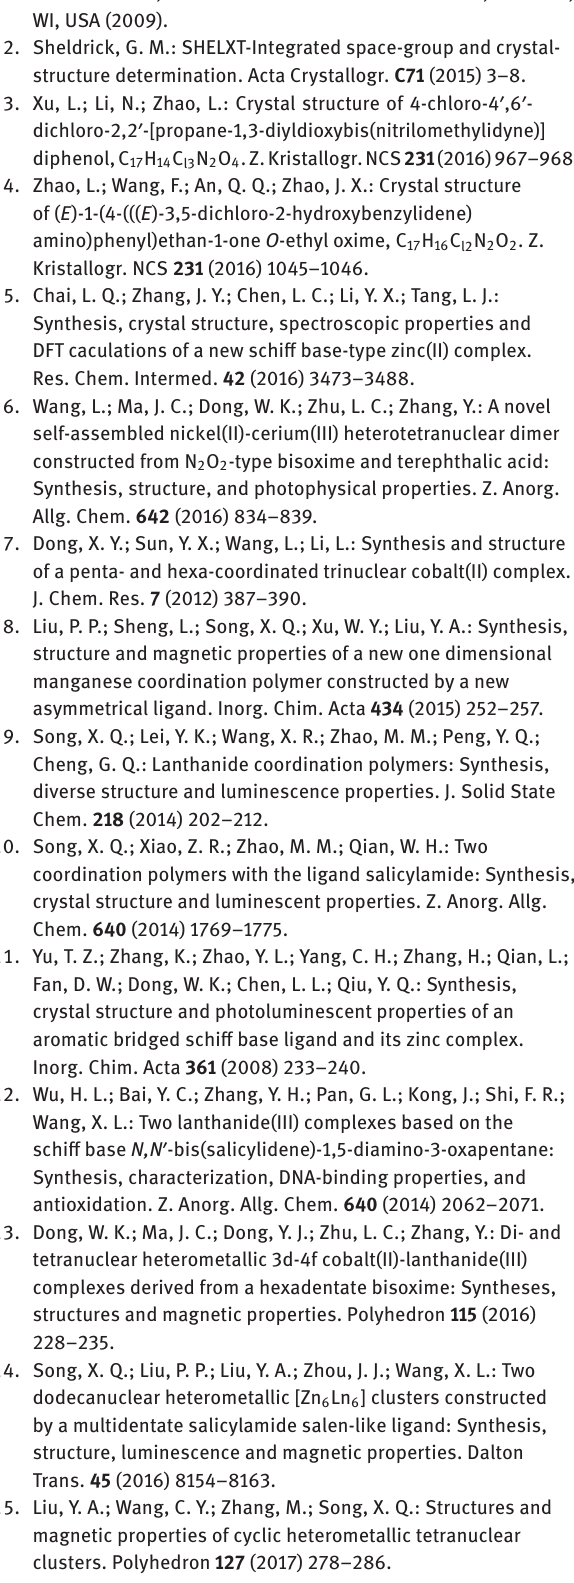
Table 2: Fractional atomic coordinates and isotropic or equivalent isotropic displacement parameters (Å 2